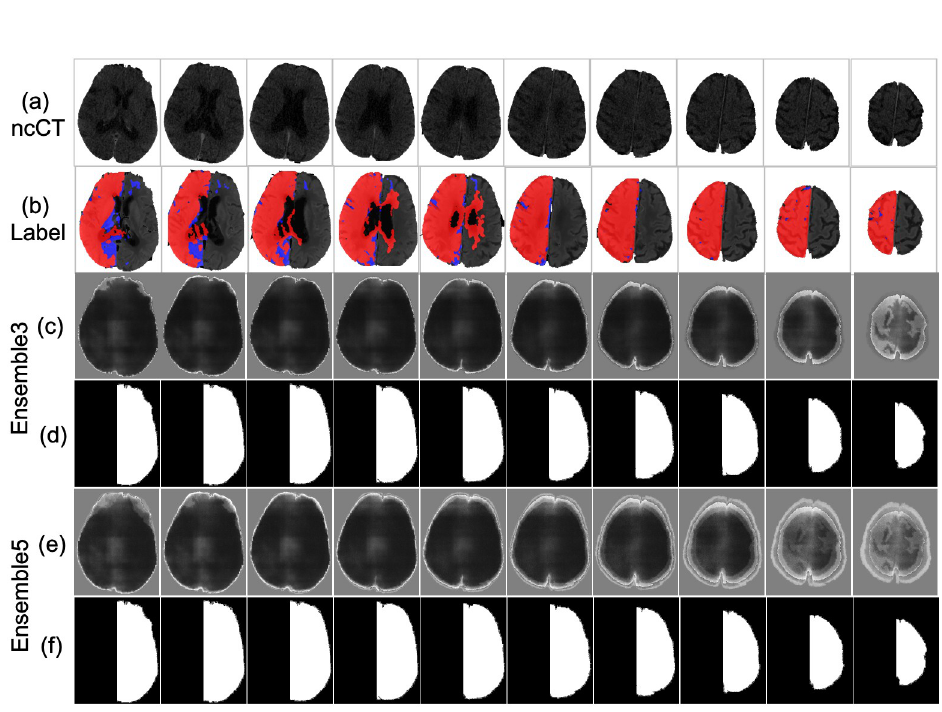
Fig 15. Lesion detection (a) ncCT and its corresponding CTp (b) of the case that achieved the lowest result due to the failed postprocessing, (b), (d) Ensemble3 and Ensemble5 without postprocessing (c), (e)Ensemble3 and Ensemble5 with